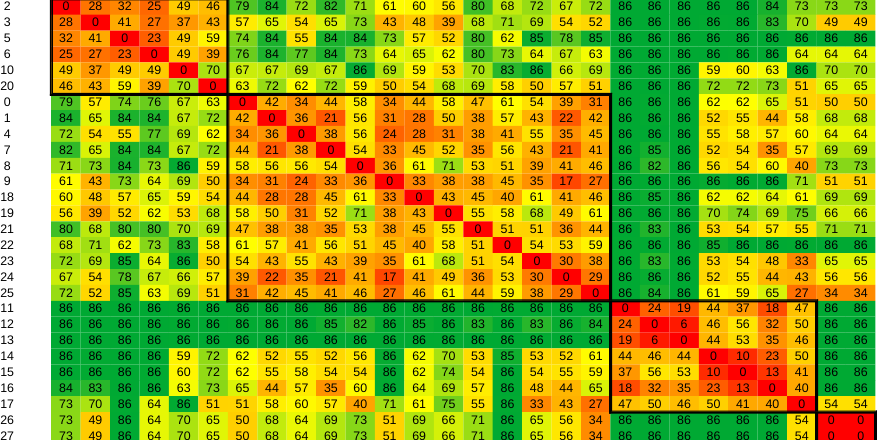
Figure 8. Distance matrix based on sensor data with ε = 0.7 for the Kasteren dataset. Values are in thousands. The background color shows gradient changes in values, with red tones indicating low values and green tones indicating high